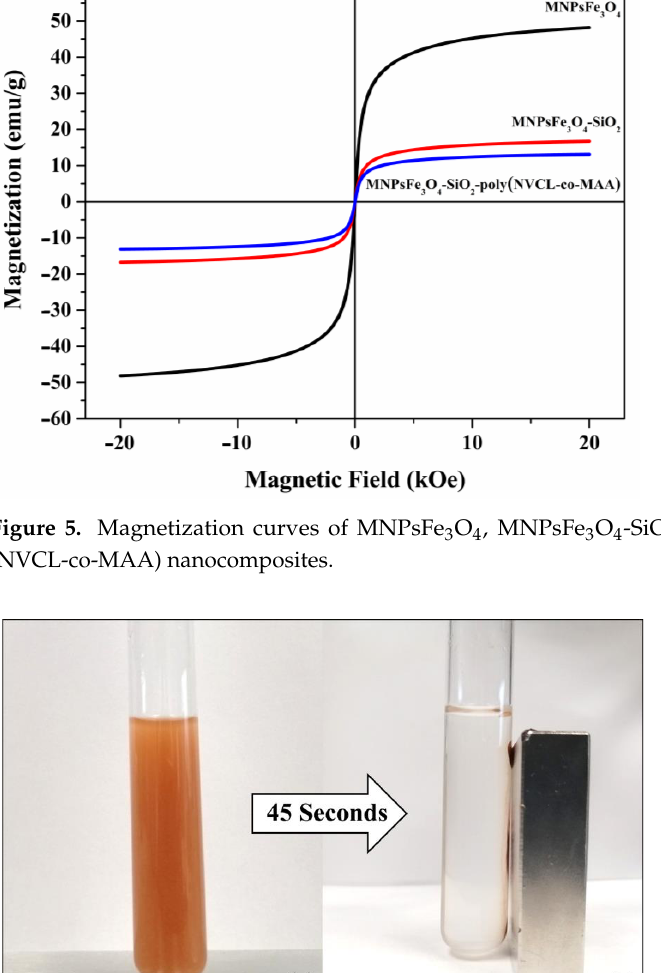
Polymers 2023 , 15 , x FOR PEER REVIEW 8 of 18 Figure 4. TGA curves of MNPsFe 3 O 4 -SiO 2 , MNPsFe 3 O 4 -SiO 2 -VTMS, and MNPsFe 3 O 4 -SiO 2 -poly (NVCL-co-MAA) nanocomposites. The magnetization curves for MNPsFe 3 O 4 , MNPsFe 3 O 4 -SiO 2 , and MNPsFe 3 O 4 -SiO 2 - poly(NVCL-co-MAA) nanocomposites are shown in Figure 5. The magnetization values have been normalized to the total mass of the sample. All the samples exhibited low val-